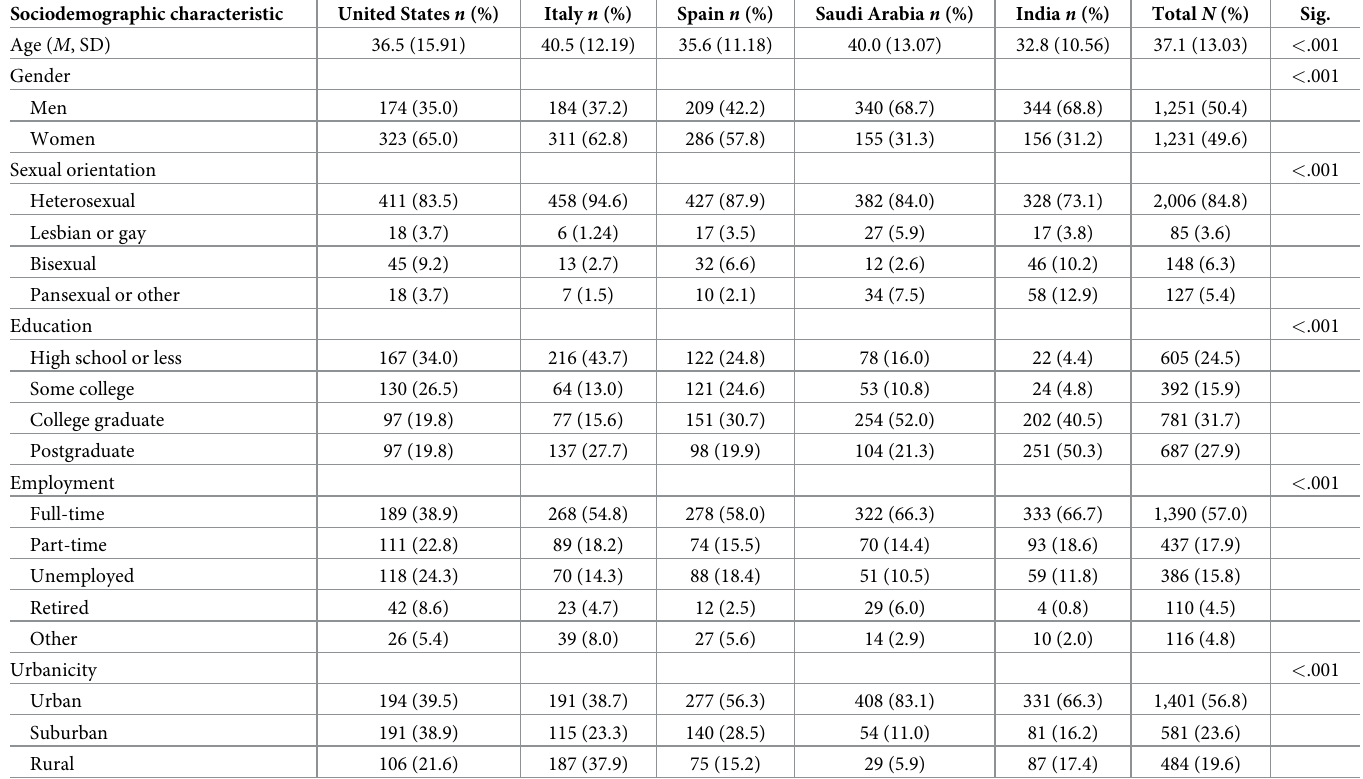
Table 1. Descriptive statistics of sociodemographic characteristics stratified by country ( N = 2,482). Sociodemographic